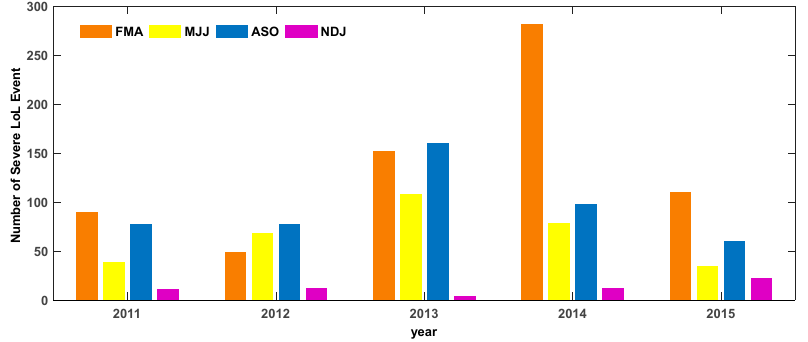
Figure 2. Seasonal statistics of loss of lock event by scintillation.